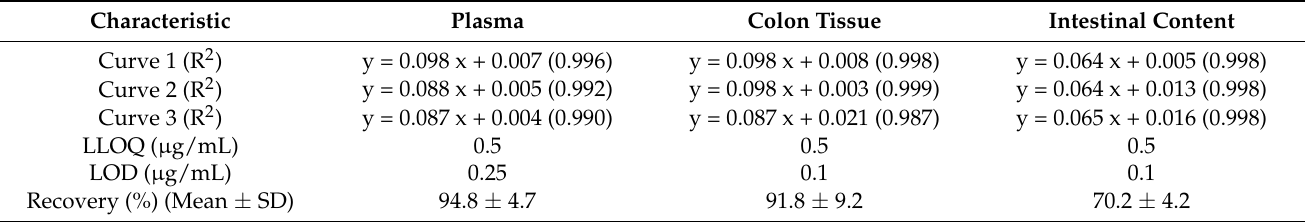
Table 1. Data from linear regression analysis of calibration